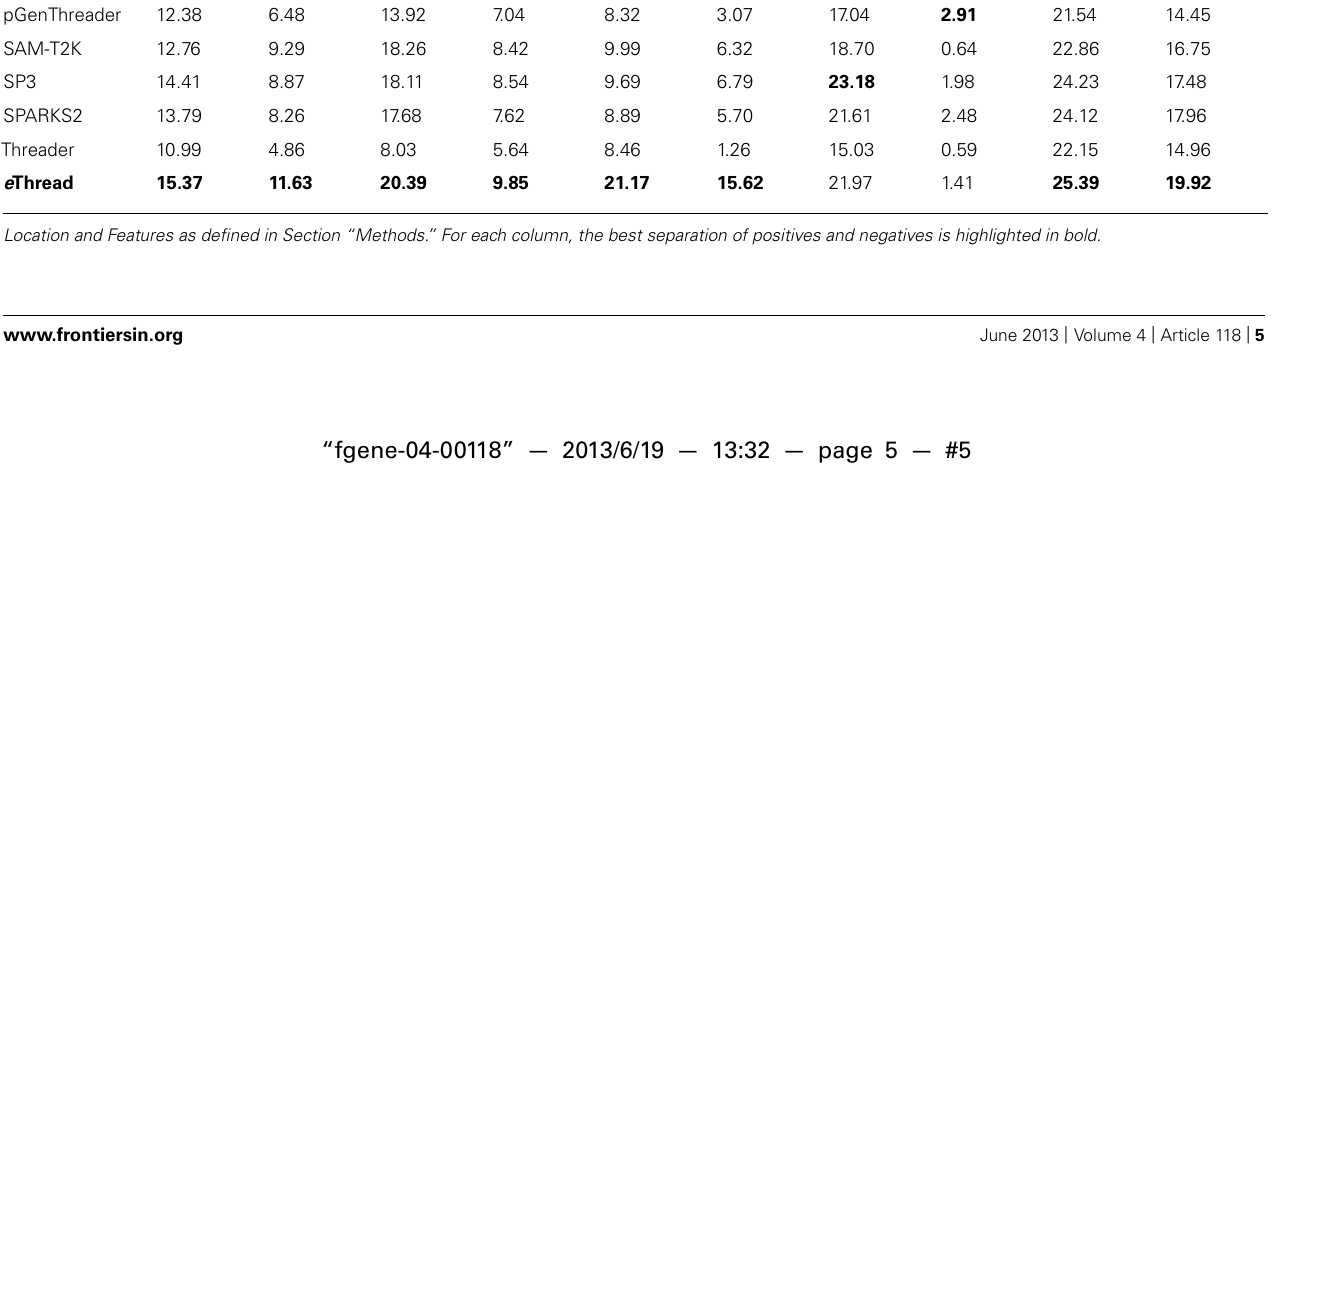
Table 3 | Z -statistics calculated by theWilcoxon rank-sum test for individual threading methods compared to that of e Thread. Method